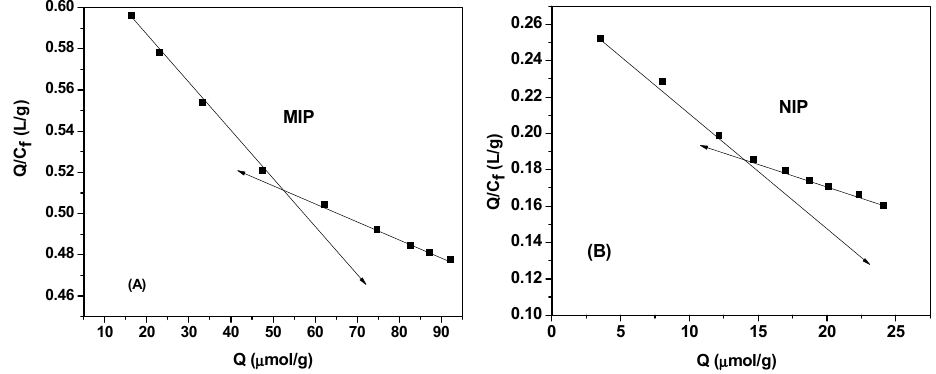
Figure 5. Scatchard plot for ( A ) MIPs and ( B ) NIPs. Conditions: 20.0 mg of polymer; t=25 °C; V=10.0 mL.